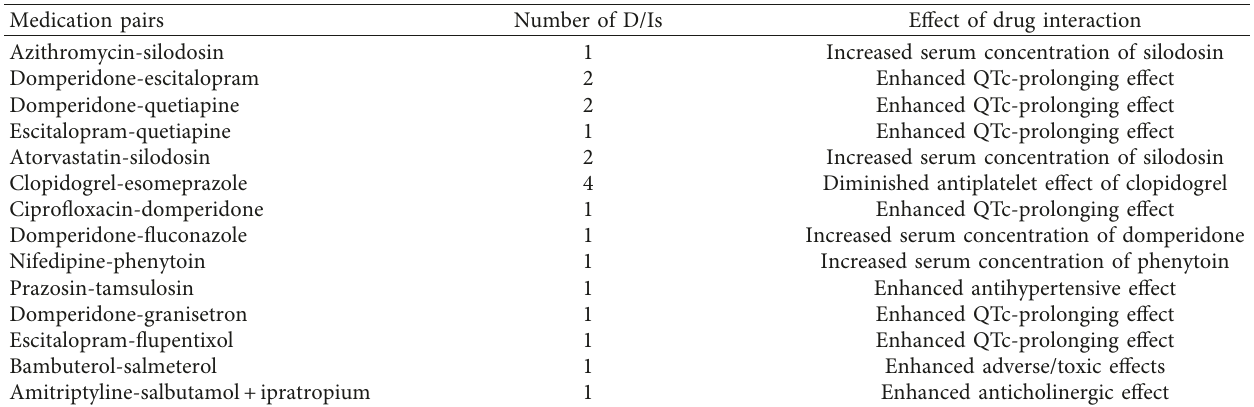
Table 6: Medication pairs involved in risk X category drug interactions (to be avoided).